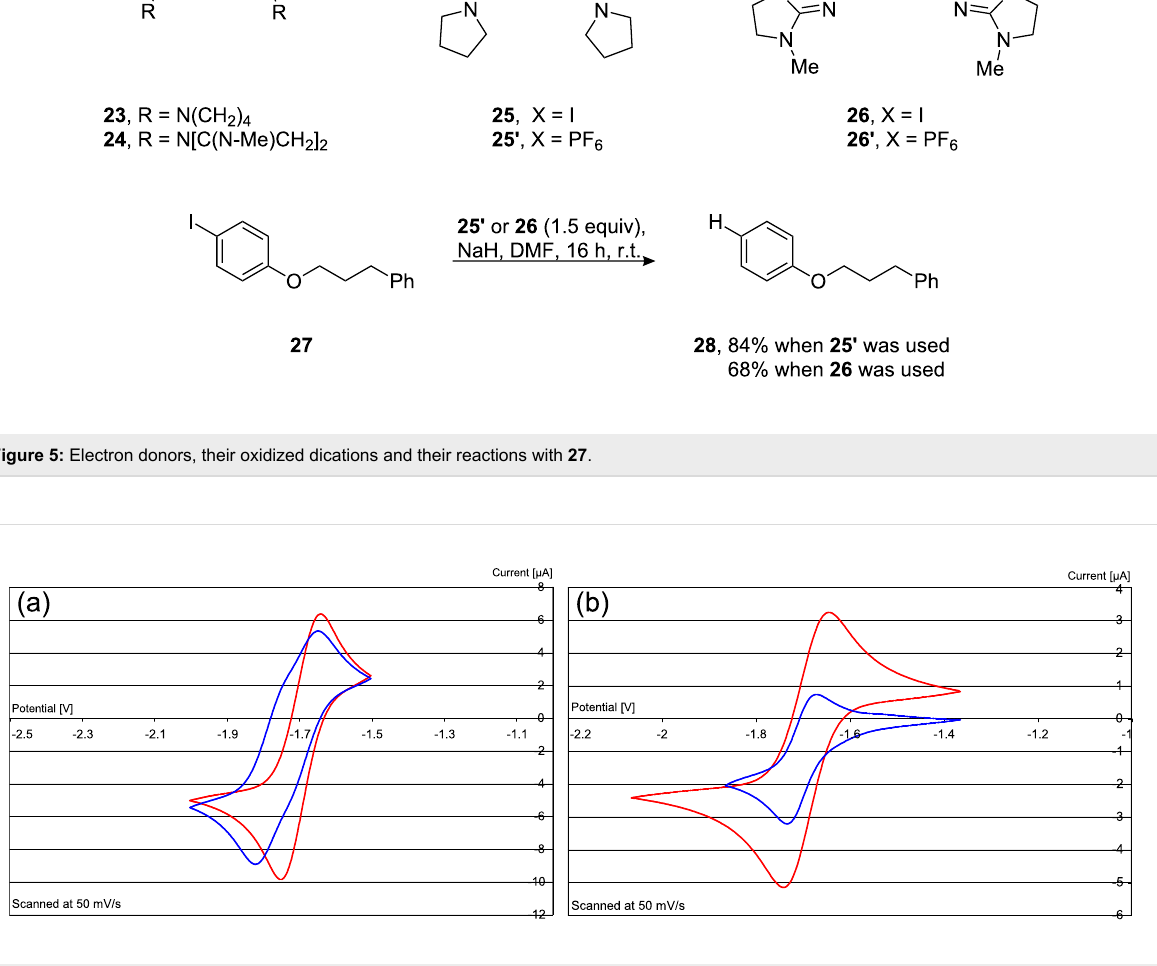
4 ′ -substituent do not lead to very large changes in the